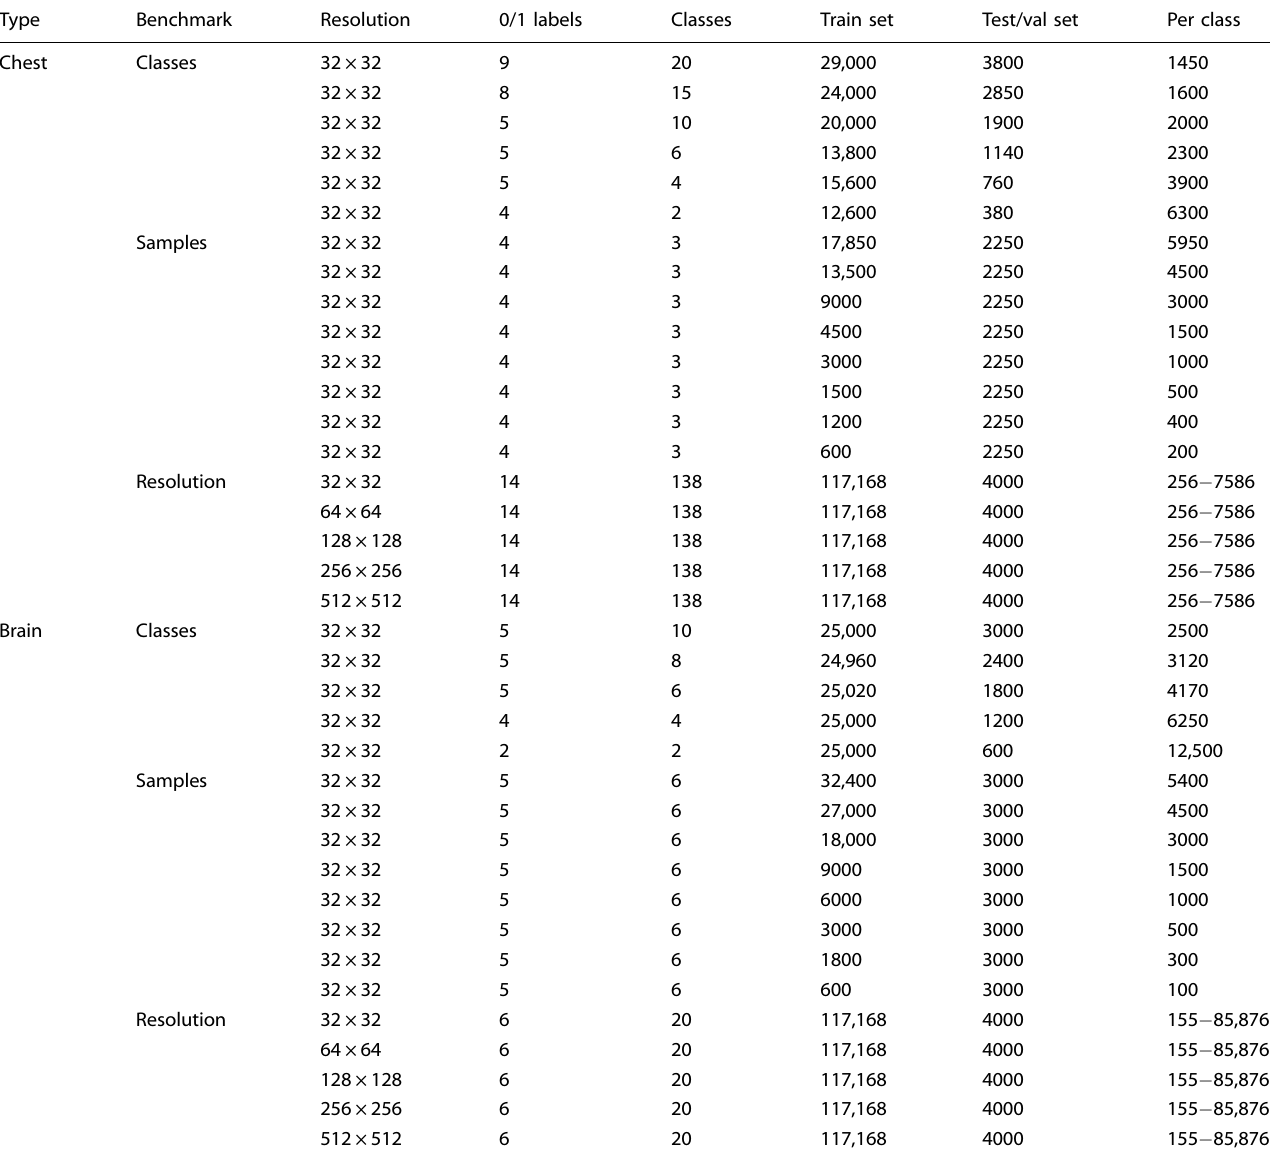
Table 1. All benchmark